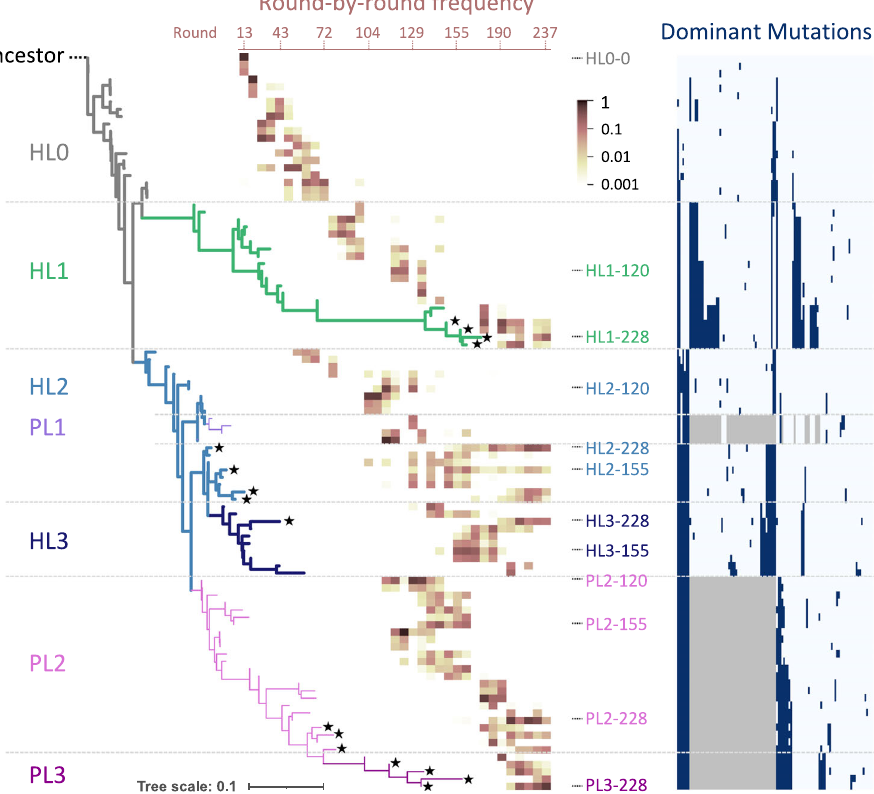
Fig. 2 Phylogeny of consensus host and parasitic RNA genotypes. The three most frequent host and parasitic RNA genotypes in all sequenced rounds are shown, with the ancestral host RNA ( “ Ancestor ” ) designated as the root of the tree. Branches comprising the de fi ned lineages are colored differently. Host (HL0 – 3) and parasitic (PL1 – 3) RNA lineages are shown as thick and thin lines, respectively. The heatmap superimposed on the tree shows the frequencies of each genotype in total host or parasitic RNA reads over all sequenced rounds (from left to right). Black star shapes at the tips of branches mark genotypes that remained in the last sequenced round. Genotypes used for biochemical analysis are indicated with the names of the corresponding RNA clones if presented in the tree. The list of dominant mutations is shown on the right; navy and gray colors indicate the presence of a point mutation and deletion, respectively. An enlarged view of the list is presented in Supplementary Fig.